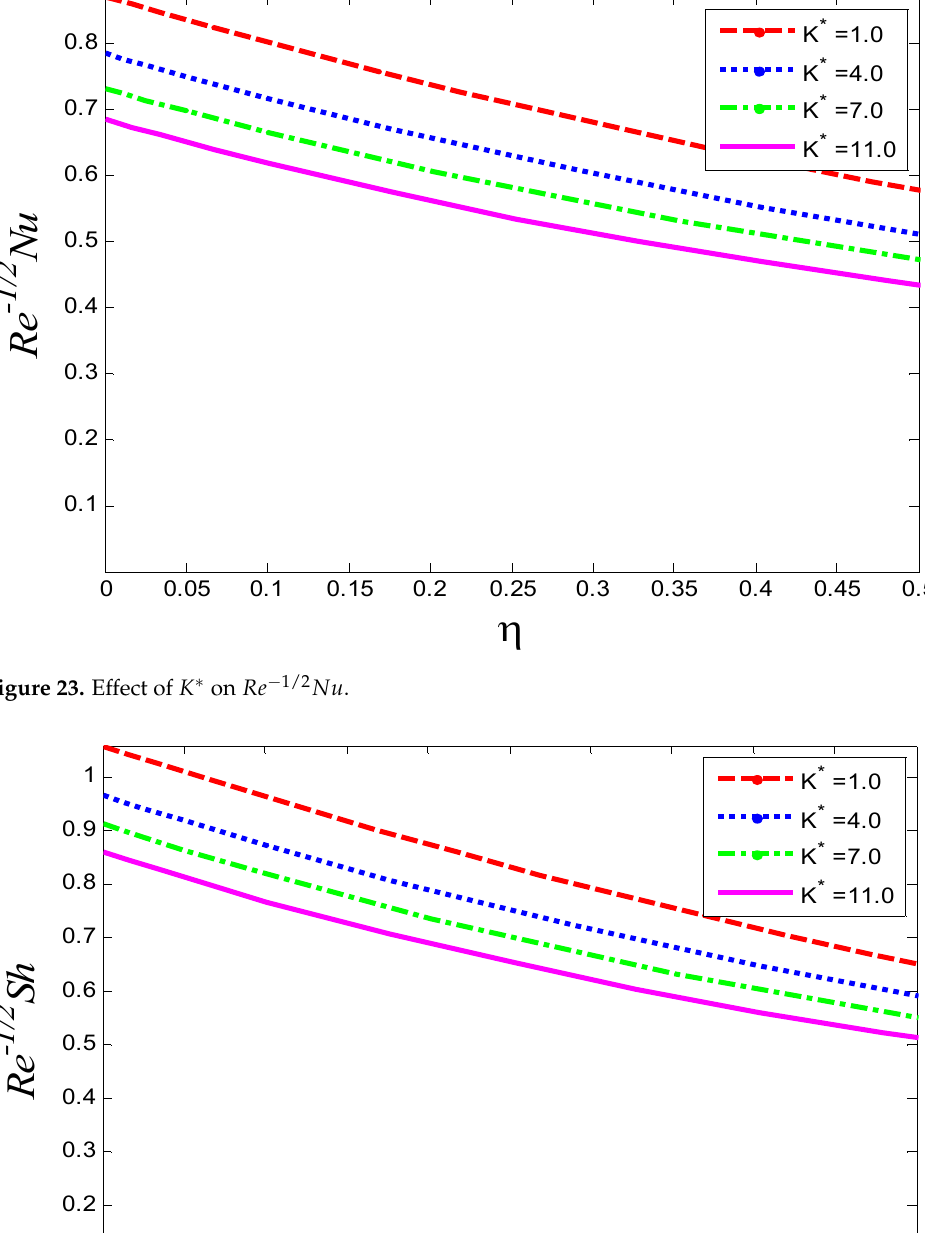
Figure 22. Effect of 𝐾 ∗ on 𝑅𝑒 (cid:2869)/(cid:2870) 𝐶 (cid:3033) .